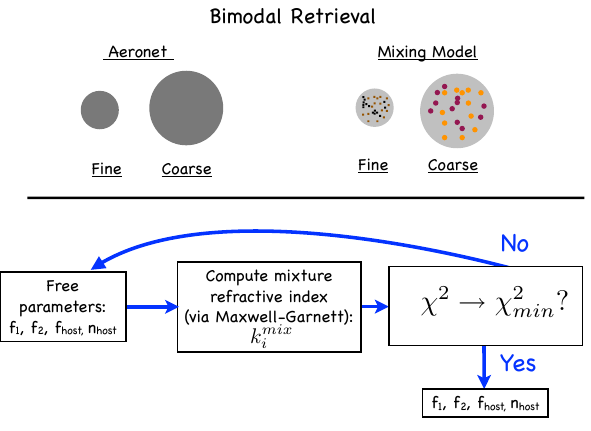
Figure 2. Schematic illustrating carbonaceous aerosol retrieval (sC and BrC) for the fine mode and free iron retrieval (goethite and hematite) for the coarse mode. AERONET provides refractive in- dices for uniform particles, and the retrieval uses different compo- nents for each mode to find a mixture that matches the AERONET refractive